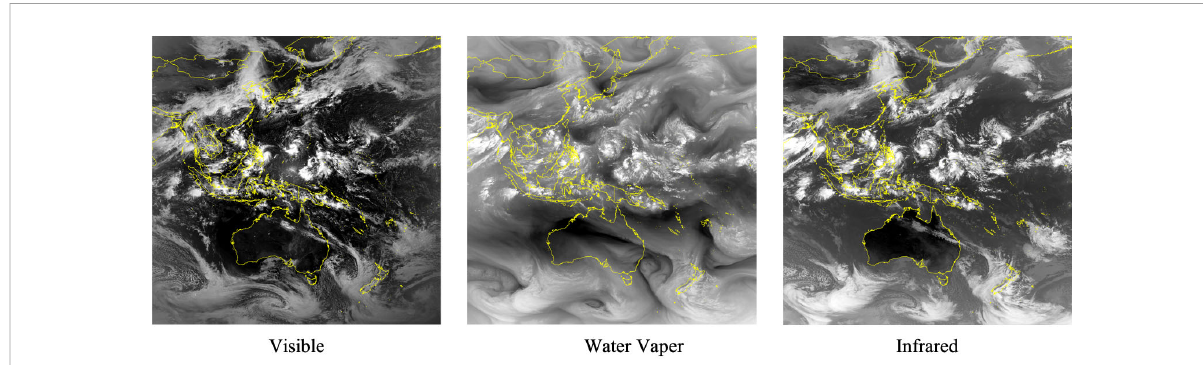
FIGURE 1 Satellite images of H8: left, a visible image; middle, a water vapor image; and right, an infrared image. The country borders in yellow show the spatial scale of the satellite